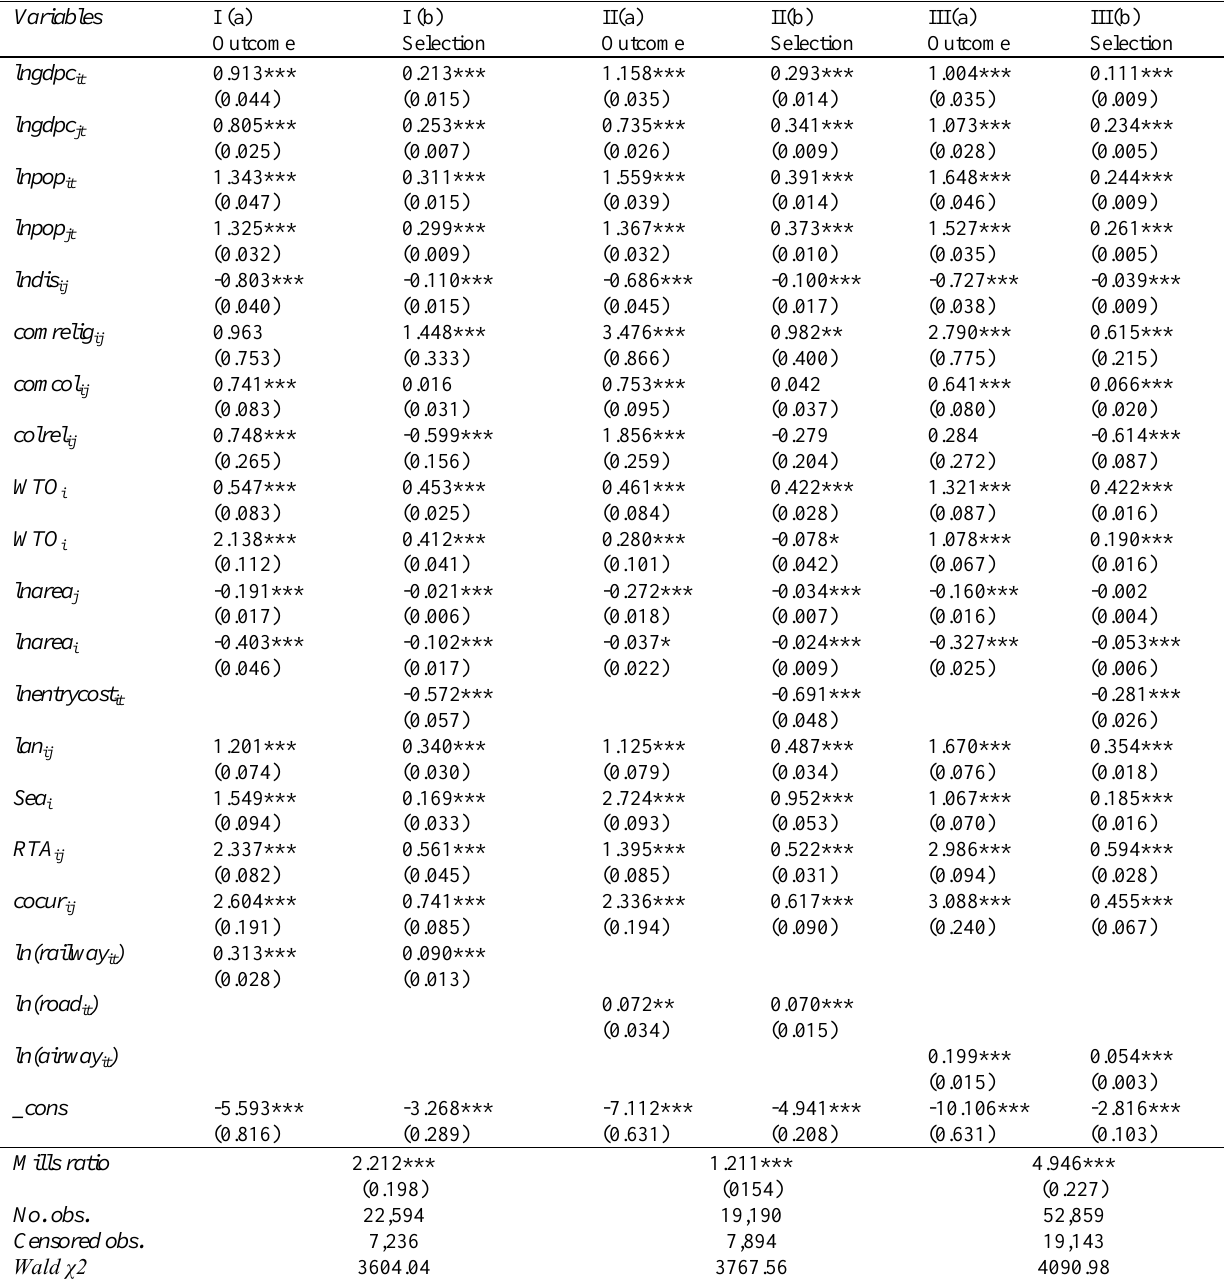
Table 11a : The impacts of separate physical infrastructure indicators on trade flow of African countries (twostep